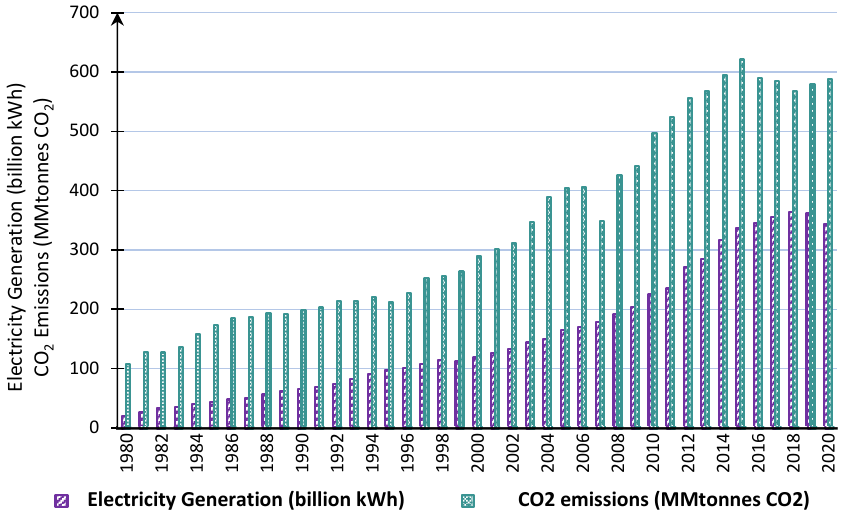
Figure 1. The growth of Saudi electricity generation and CO 2 emissions through four decades. The design and operation of buildings in the KSA in ways that do not take into ac- count energy efficiency led to a weakness in the thermal performance of these building envelopes [1]. Studies show that 70% of existing residential buildings are not thermally insulated. As a result, and due to the harsh climate in most Saudi regions, 70% of the total electrical energy is consumed by air conditioning systems to achieve indoor thermal com- fort. It turns out that government buildings are accounting for about 13% of the total elec- tricity generated in the kingdom [12]. Due to the weak climatic design considerations for buildings and the focus on a unified design for government buildings in many somewhat different climatic regions in the Kingdom, most of this energy goes to cooling the interior spaces to provide a suitable thermal environment for employees and visitors. It is